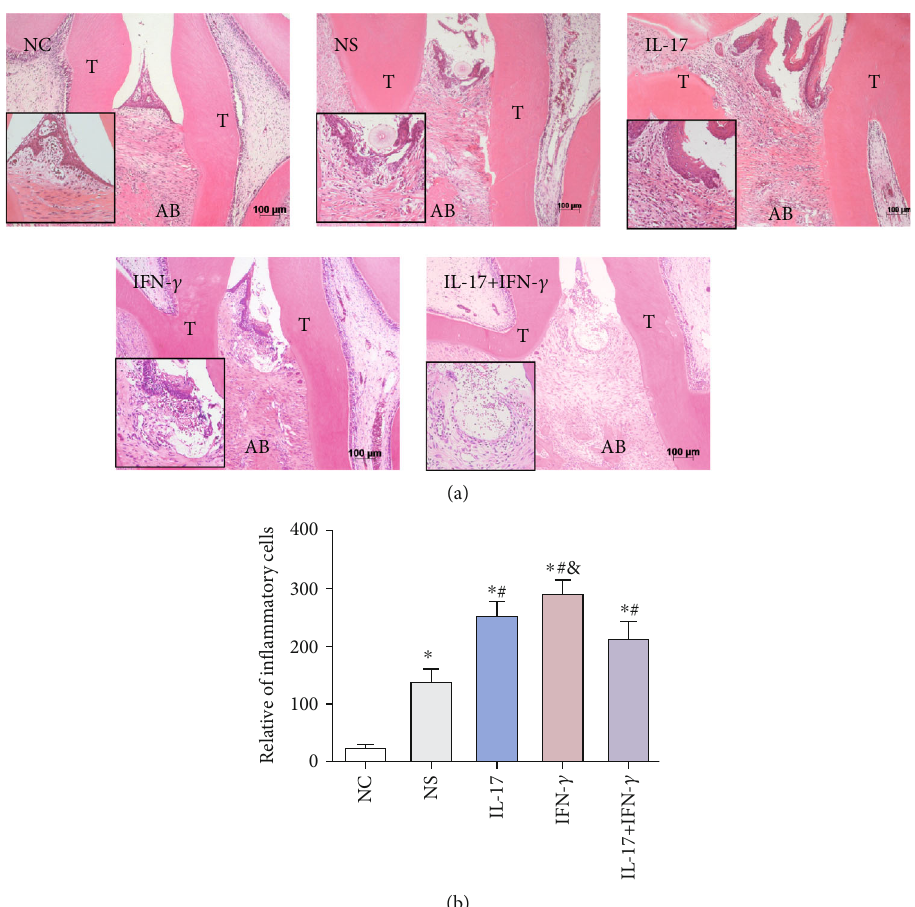
Figure 3: Role of IL-17 (5 μ g/ml) or/and IFN- γ (1 μ g/ml) on local gingival in fl ammation in an experimental periodontitis rat model. (a) HE staining showed the periodontal morphology in the interradicular regions of the fi rst maxillary molars of the NC, NS, IL-17, IFN- γ , and IL-17 +IFN- γ groups ( scale bar = 100 μ m ). (b) Quantitative analysis was performed on the number of in fl ammatory cells of each group ( mean ± standard deviation , n = 5 ). ∗ p < 0 : 05 compared with the NC group, # p < 0 : 05 compared with the NS group, and & p < 0 : 05 compared with the IL-17+IFN- γ group. T: tooth; AB: alveolar e ff ect of IL-17 and/or IFN- γ on the periodontal tissue in vivo ,